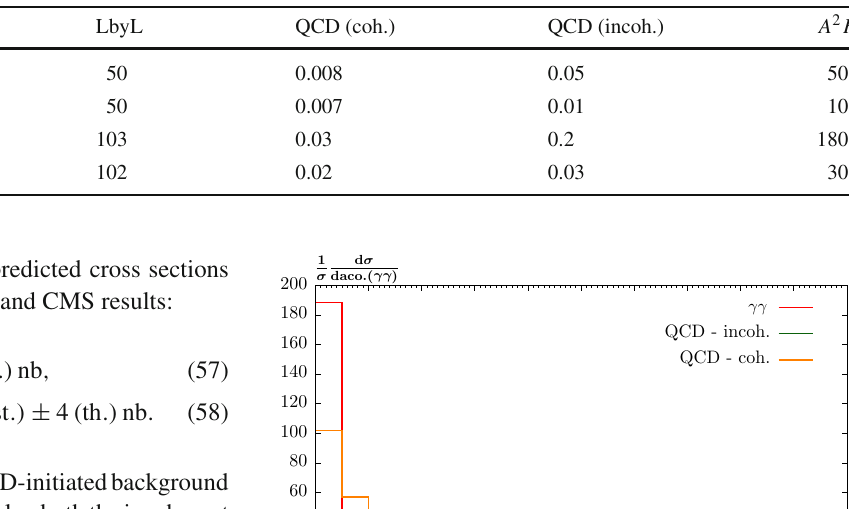
Table 2 Predicted cross sections, in nb, for diphoton final states within the ATLAS [21] and CMS [22] event selections, in Pb–Pb collisions √ s = 5 . 02 TeV. That is, the photons are required to have trans- at γ > 2 (3) GeV and pseudorapidity | η γ | < 2 . 4, while in verse energy E ⊥ the CMS case an additional cut of m γγ > 5 GeV is imposed. Results with and without an additional acoplanarity cut aco < 0.01, and cut